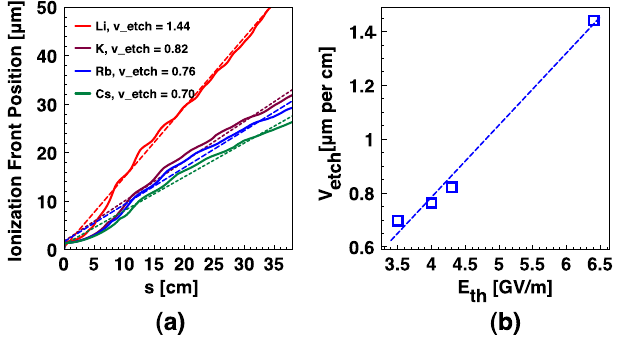
FIG. 5. Ionization front etching in different gases: (a) receding of the ionization front in different alkaline metal gases; (b) the etching velocity verses the neutral gas ionization